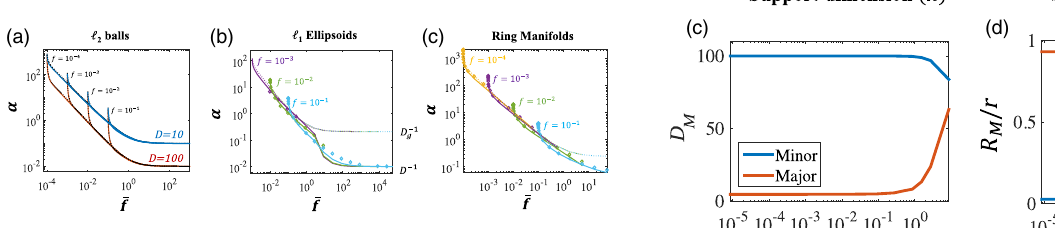
FIG. 11. (a),(b) Classification of l 2 balls with sparse labels. ¯ f ¼ f ð 1 þ r 2 Þ , for D ¼ (a) Capacity of l 2 balls as a function of FIG. 12. Manifold configurations and geometries for classifi- 100 (red) and D ¼ 10 (blue) mean-field theory results. Overlaid cation of l 1 ellipsoids with sparse labels, analyzed separately in black dotted lines represent an approximation interpolating terms of the majority and minority classes. The radii for l 1 between Eqs. (55) and (57) (details in SM [16], Sec. S9). (b), 1 r for 1 ≤ i ≤ 10 and R r for ellipsoids are R (c) Classification of general manifolds with sparse labels. 2 i ¼ i ¼ 11 ≤ i ≤ 100 , with r ¼ 10 . (a) Histogram of support dimensions (b) Capacity of l 1 ellipsoids with D ¼ 100 , where the first 10 for moderate sparsity f ¼ 0 . 1 : minority (blue) and majority (red) components are equal to r , and the remaining 90 components are ¯ 1 manifolds. (b) Histogram of support dimensions for high sparsity r , as a function of f ¼ f ð 1 þ R 2 . r is varied from 10 − 3 to 10 3 : 2 g Þ f ¼ 10 − 3 : minority (blue) and majority (red) manifolds. (c) Mani- numerical simulations (circles), mean-field theory (lines), spheri- ¯ f ¼ f ð 1 þ R 2 fold dimension as a function of as f is varied: cal approximation (dotted lines). (c) Capacity of ring manifolds g Þ minority (blue) and majority (red) manifolds. (d) Manifold radius with a Gaussian falloff spectrum, with σ ¼ 0 . 1 and D ¼ 100 ¯ (details in SM [16]). The Fourier components in these manifolds f : minority (blue) relative to the scaling factor r as a function of 2 π ð n − 1 Þ σ (cid:3) 2 Þ . A exp ð − 1 and majority (red) have a Gaussian falloff, i.e., R 2 ½ n ¼